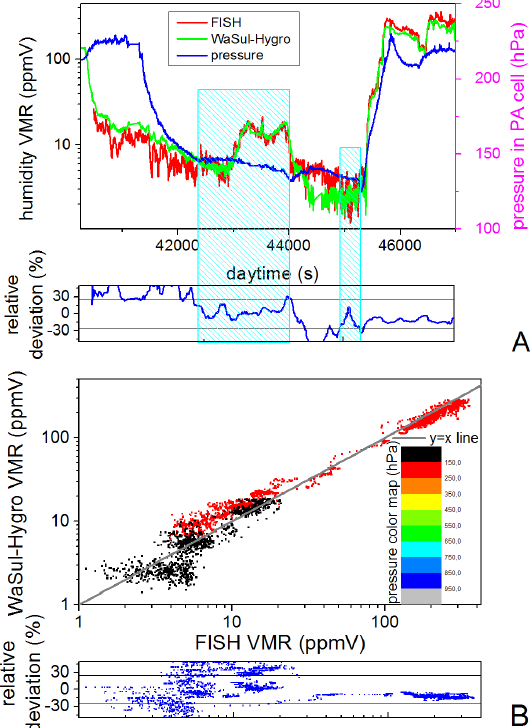
Figure 7. A representative comparison flight measurement of WaSul-Hygro and the WS-CRDS system (DENCHAR flight, 26 May 2011). (a) is the time series of the measurements; (b) is the corresponding cross plot, where the pressure is coded by color. The relative deviation below ∼ 30ppmV is higher than 15%, and is not indicated in plot (b)